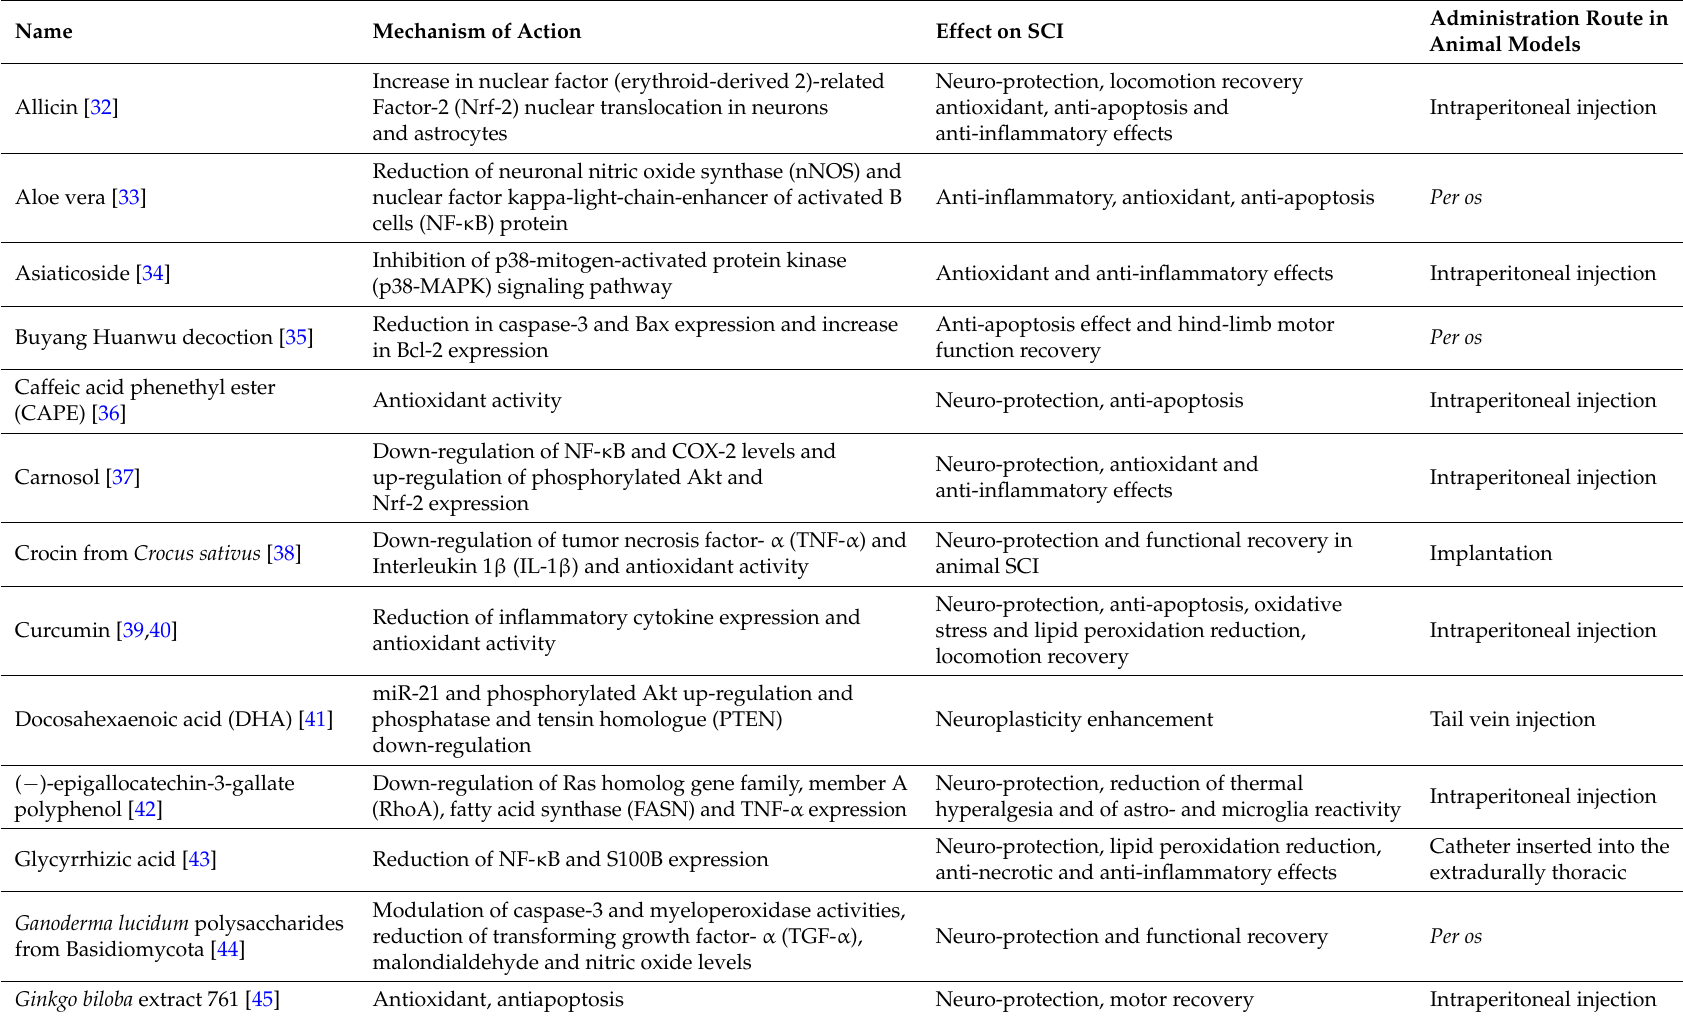
Table 2. Vegetal extract components reported in the literature over the last two years as potentially effective in the treatment of